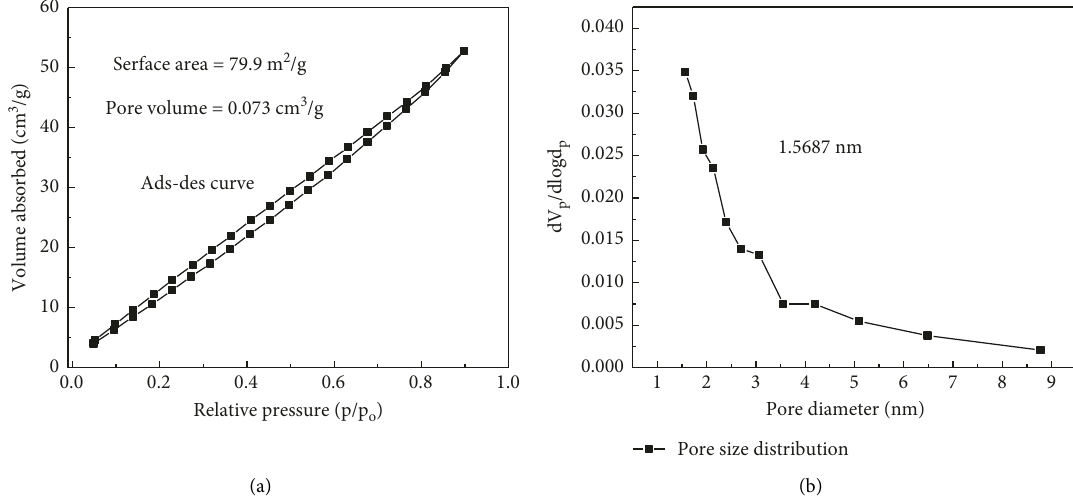
Figure 6: (a) Nitrogen adsorption-desorption isotherms and (b) pore size distribution curves for Cu-ZnO (3%) with plant extract.